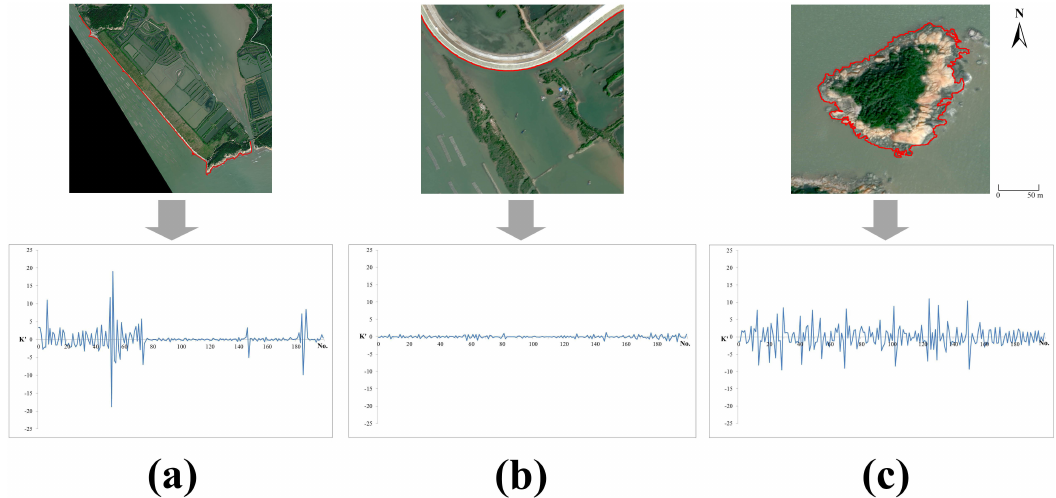
Figure 11. Examples of slope change rate curves from different shore polygon edges. ( a ) Slope change rate curves of the area with both the artificial shore and the natural shore. ( b ) Slope change rate curves of the artificial shore. ( c ) Slope change rate curves of the natural shore.